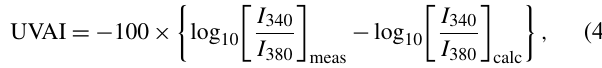
Figure 2. Lidar range-corrected signal at 1064nm on 24–25 Au- gust 2017 measured by LILAS. The solid red line indicates the sun- rise time. The two dashed red lines point out the approximate layer base before and after the sunrise. The sunrise and sunset times are 04:51 and 20:47UTC, respectively. The corresponding daytime du- ration is about